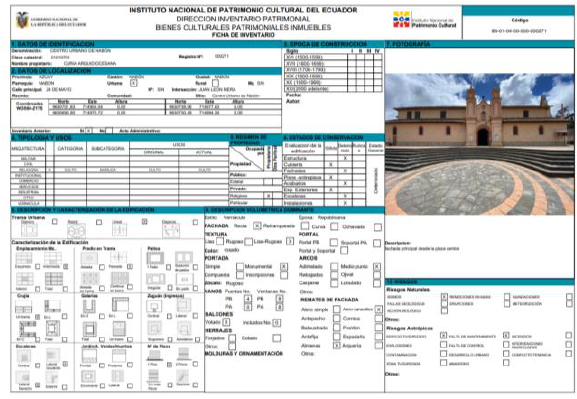
Figure 5 . Nabón’s church inventory